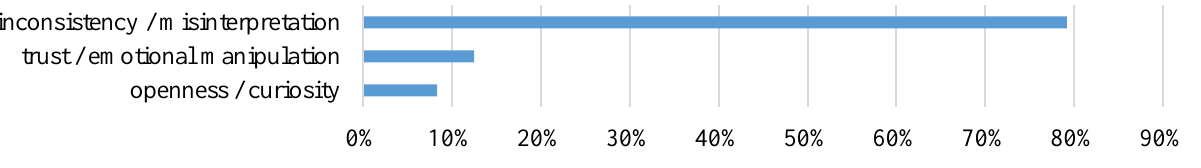
Figure 5 . Survey results for Hypothesis 2 . Figure 5. Survey results for Hypothesis